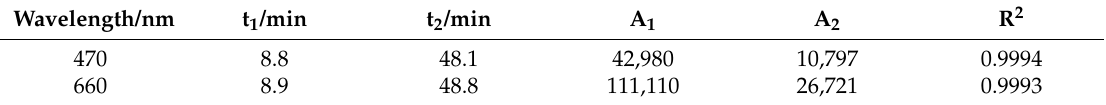
Figure 4. Afterglow decay of the CASN/SMS (1/4, by weight) nanocomposite film: ( a ) Emission at 470 nm/660 nm, ( b ) red/blue intensity ratio, Int.(660 nm/Int.(470 nm), within 300 min. A 10 min delay was used because of the intense luminescence intensity at the start of the decay process and the over range protection of the fluorophotometer. Table 1. Decay kinetic parameters of the afterglow emission of CASN/SMS (CASN content, 20 wt %) nanocomposite.